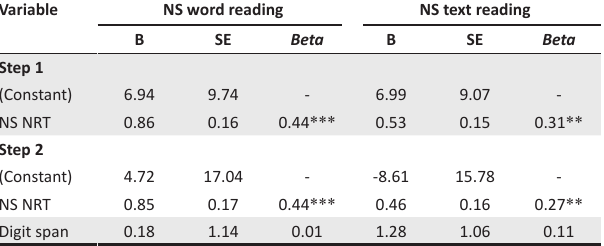
TABLE 4: Hierarchical regression analyses with NS Word reading and, NS text reading as dependent variables and NS NRT and digit span as predictors. Variable